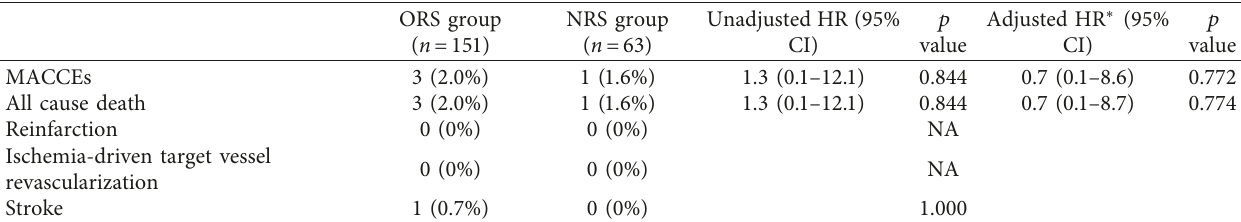
Figure 2: Radiation dose comparison among X-ray systems within groups. ORS, optimized radiation strategy; NRS, normal radiation strategy. Table 3: Clinical Outcomes at